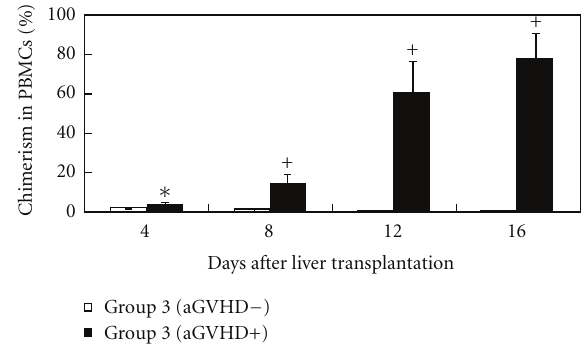
Figure 5: association of chimerism with aGVHD. PBMC chimer- ism following sex-mismatched liver transplantation was identified by real-time PCR based on a rat Y-chromosome-specific primer, as described in Materials and Methods (Section 2). As described in Materialsand Methods (Section 2), group 3 received semiallogeneic liver transplantation together with the transfusionof 2 × 10 8 spleno- cytes. Group 3 (aGVHD-), shown as white bars, consisted of 6 ani- malsthat were free from aGVHD, group 3 (aGVHD+) consisted of 6 animals with aGVHD following transplantation ∗ P < . 05, + P < .